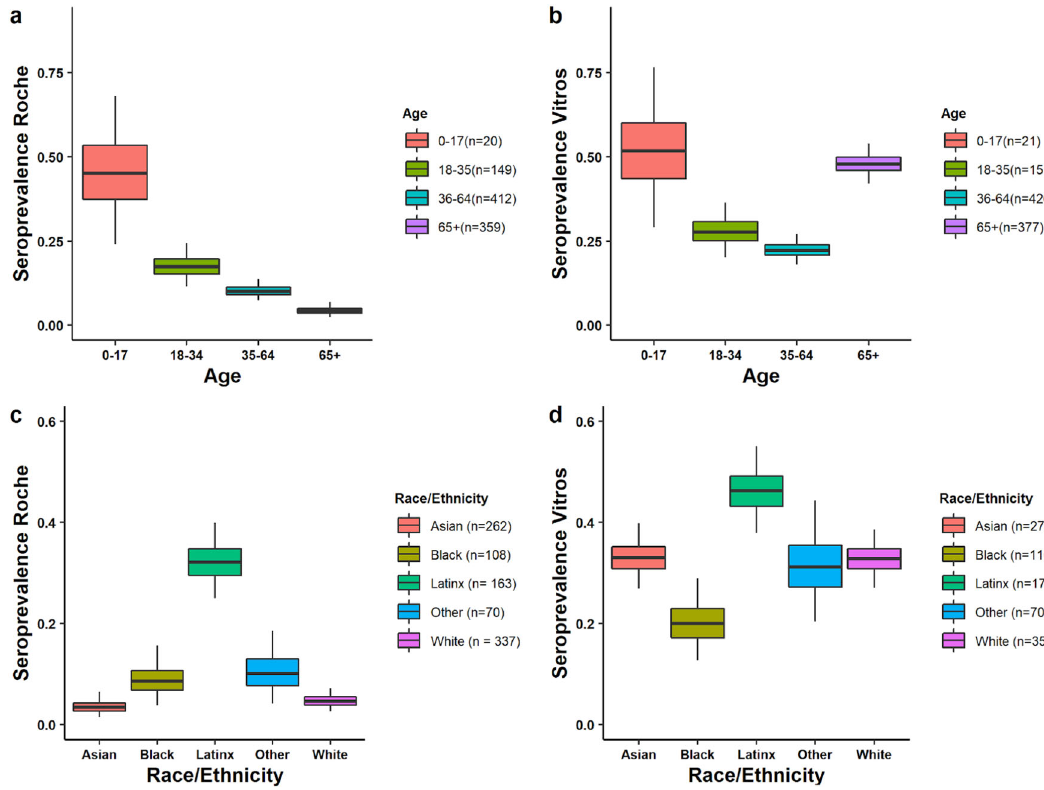
Fig. 4 Strati fi ed seroprevalence by assay and by demographic group. a Univariate Roche seropositivity estimates by age (elicited by prior infection). b Univariate Vitros estimates by age (elicited by either prior infection or vaccination). c Univariate Roche estimates by race/ethnicity. d Univariate Vitros estimates by race/ethnicity. For all panels, the center line of the box and whisker diagram represents the median posterior estimate, the box represents the 25-75 th percentile values of the posterior, and the whisker lines show the 95% Credible